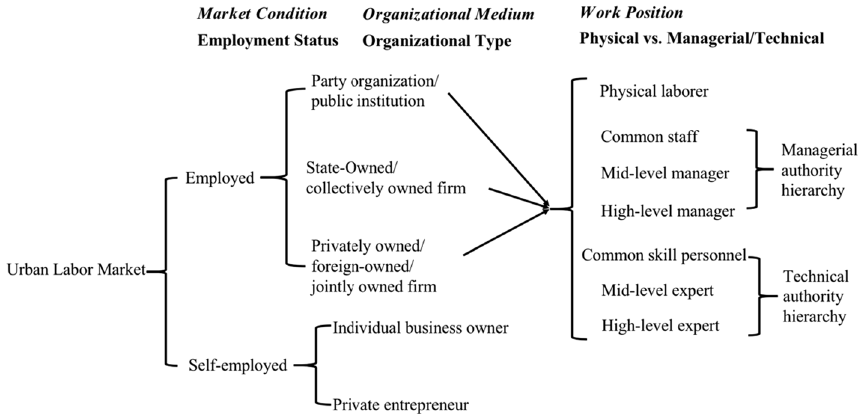
Fig. 1 Conceptualization of work